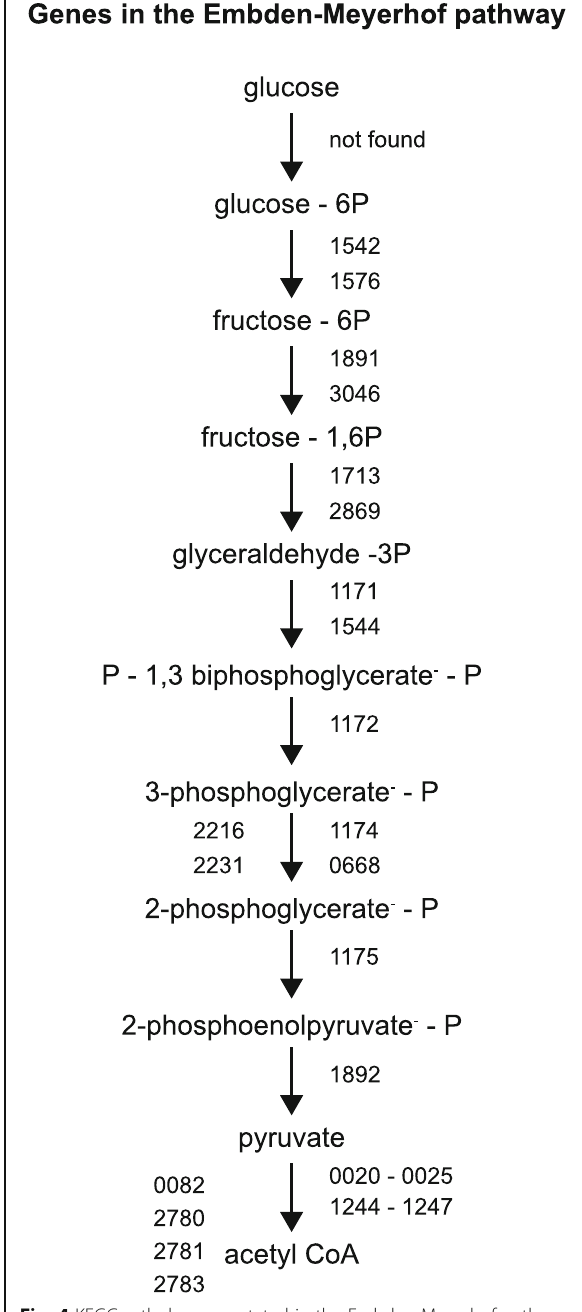
Fig. 4 KEGG orthologs annotated in the Embden-Meyerhof pathway of organic carbon assimilation in D. alkaliphilus strain AHT1 T . The numbers of the locus tags of the genes catalyzing each reaction are indicated and must be preceded by DealDRAFT_